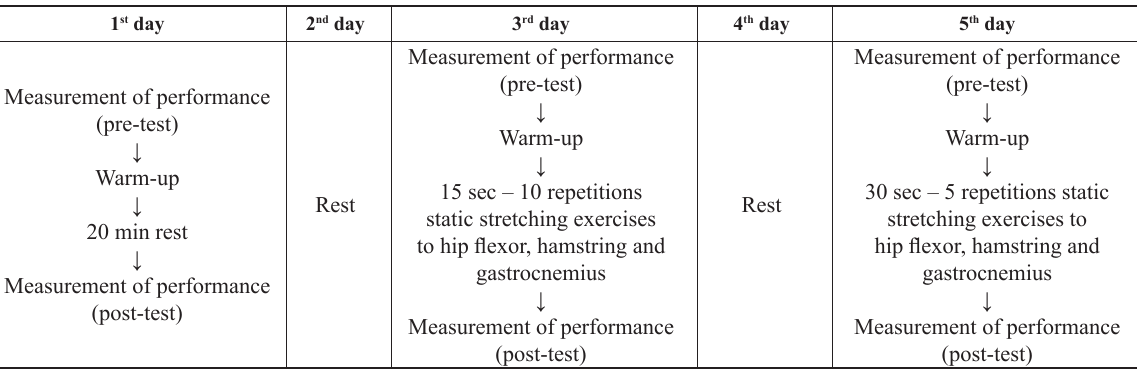
Table 1. Stretching protocols applied to athletes in this